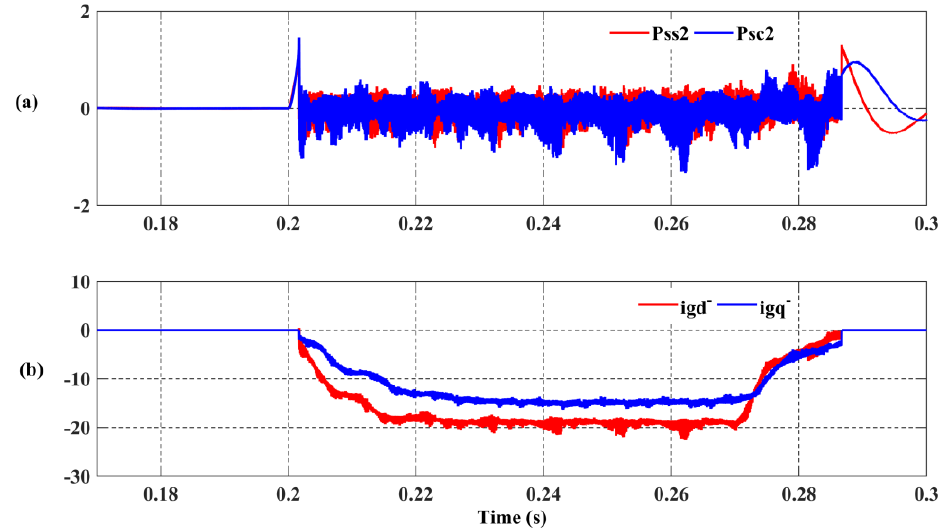
Figure 13. Simulation C results with external P ss2 -P sc2 controllers: ( a ) P (kW) and Q (kVAr), ( b ) grid currents (A).